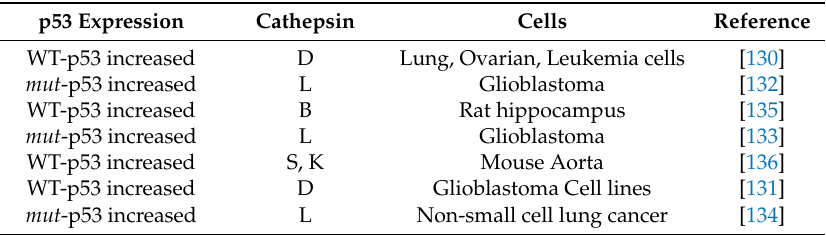
Table 1. Wild Type (WT) or mutant (mut) p53 with cathepsin protein expression levels can be positively correlated in a variety of cancer cell lines and